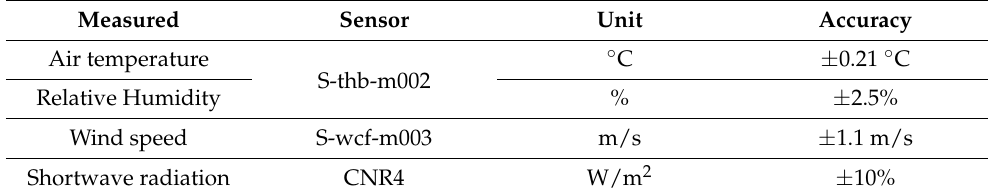
Table A1. Parameters list measured and information of measurement sensor. Measured Sensor Unit Accuracy Air temperature S-thb-m002 Relative Humidity Wind speed Shortwave radiation